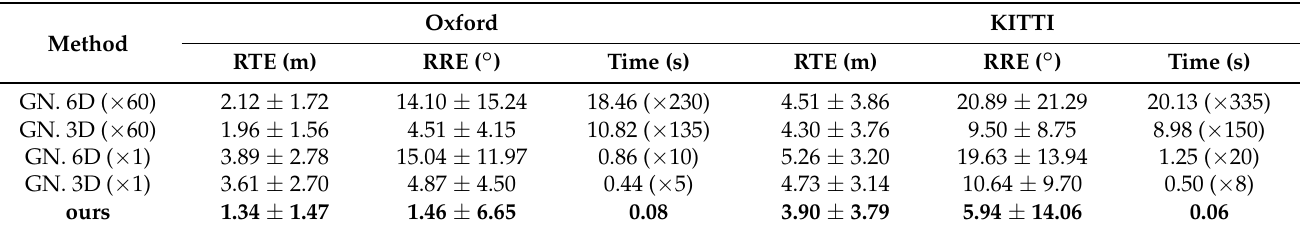
Table 3. Registration efficiency evaluation on both Oxford and KITTI datasets. In addition to the average value and standard deviation of RTE and RRE, the mean inference time during camera pose optimization is reported. The × 230-like numbers in the time column show the multiplier of large speed-up. For the Gauss–Newton solver, different initial times and various optimization space are compared. The best results are shown in